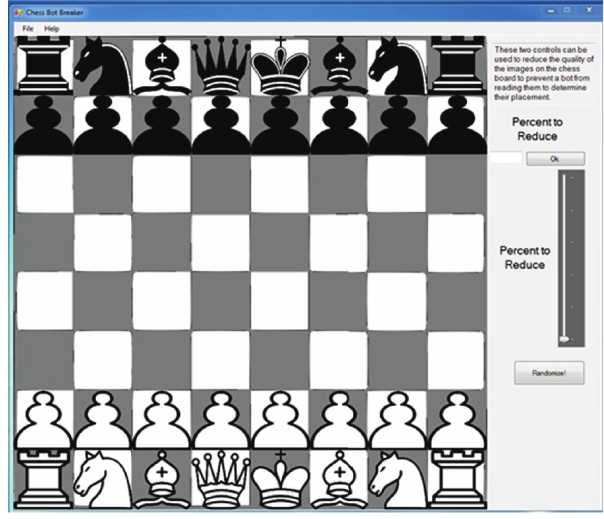
Figure 2: Standard chess board